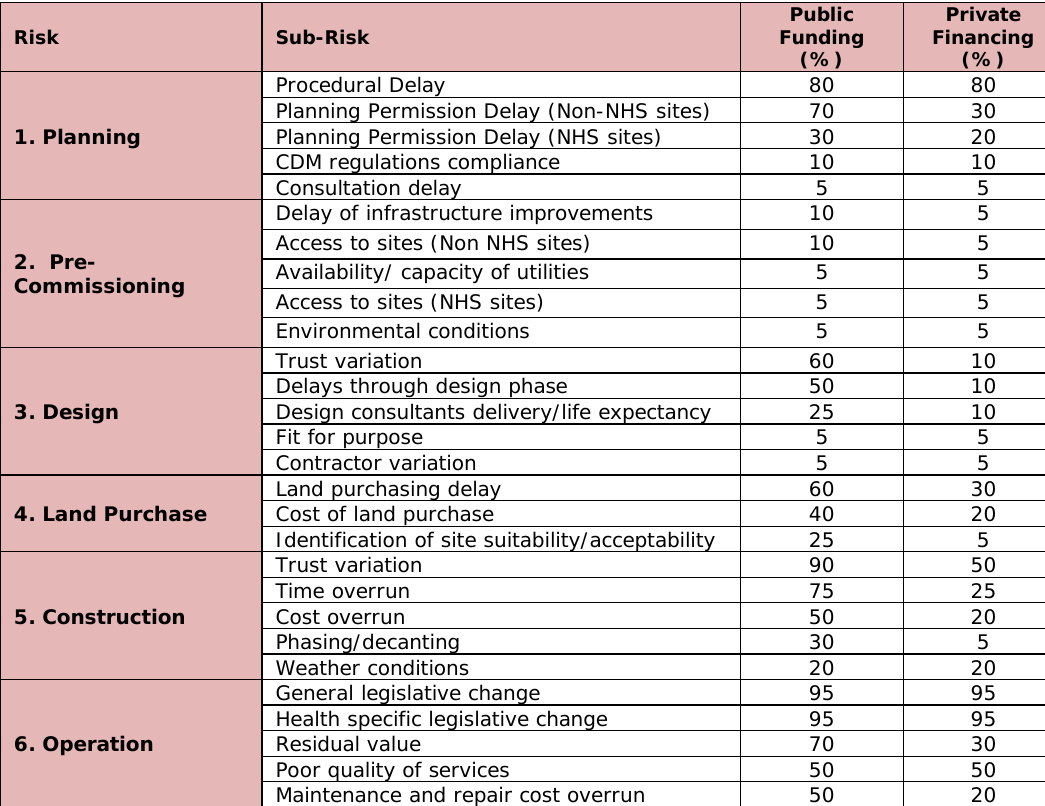
Table 1. "Actual Probability Estimates for Key Risks". Source: LMHT